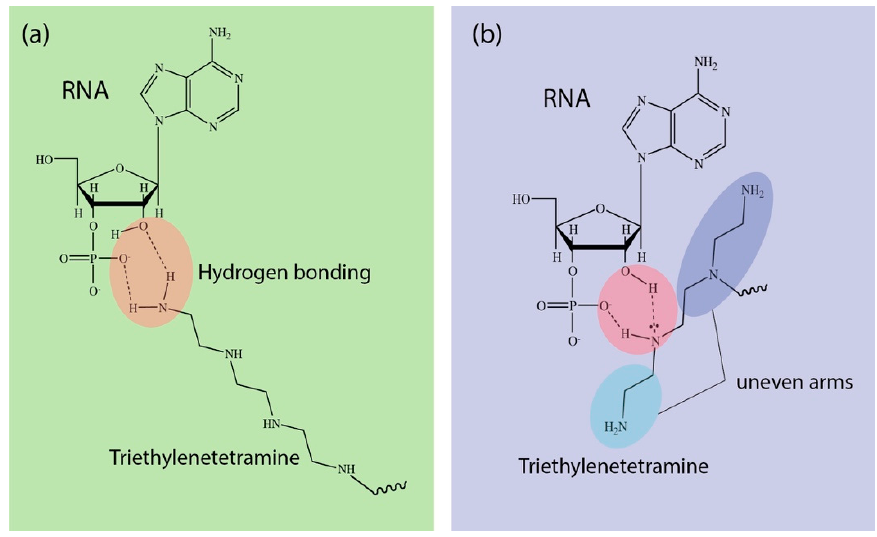
Figure 4. Hydrogen bonding of TET via ( a ) tail group amine and ( b ) secondary amine resulting in “uneven” chain arms.